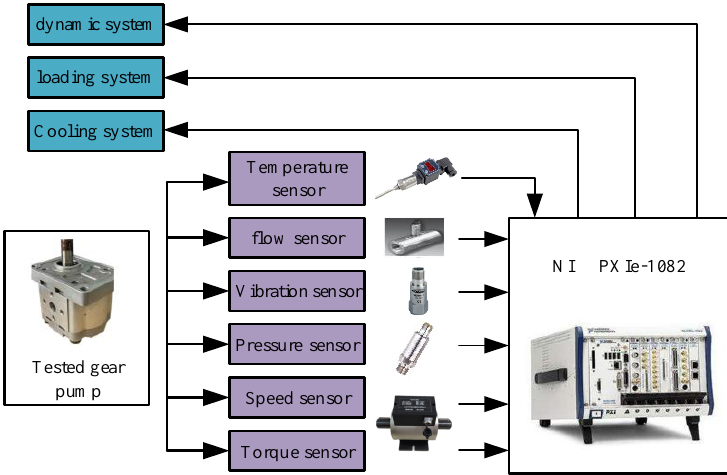
Figure 19. Measurement and control hardware structure of test device.